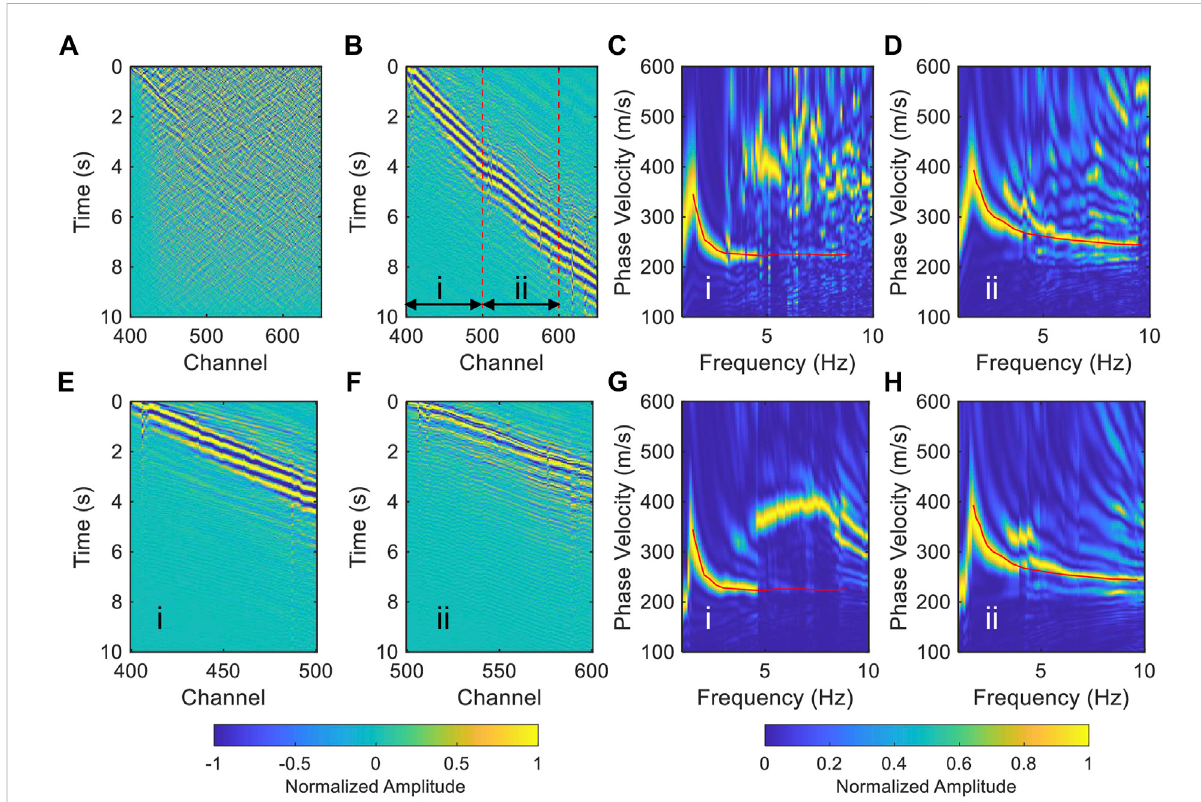
FIGURE 10 The feasibility test of the TSI method in the heterogeneous subsurface structure. (A) The raw common virtual-shot gather of the long segment (gray dashed box in Figure 1). (B) The NCFs after the TSI method. The red dashed lines divided the long segment into sub-segments i (CH400-500) andii(CH500-600)fordispersioncurvecalculation. (C,D) arethedispersionspectraofthesub-segment(i)and(ii)cutfrom (B) . (E,F) arethedenoised waveforms of the segments of (i) and (ii), respectively. (G) and (H) are the dispersion spectra of (E,F) , respectively. The red lines in (C,G) are the dispersion curves extracted from (C) , while the red lines in (D,H) are the dispersion curves extracted from (D)